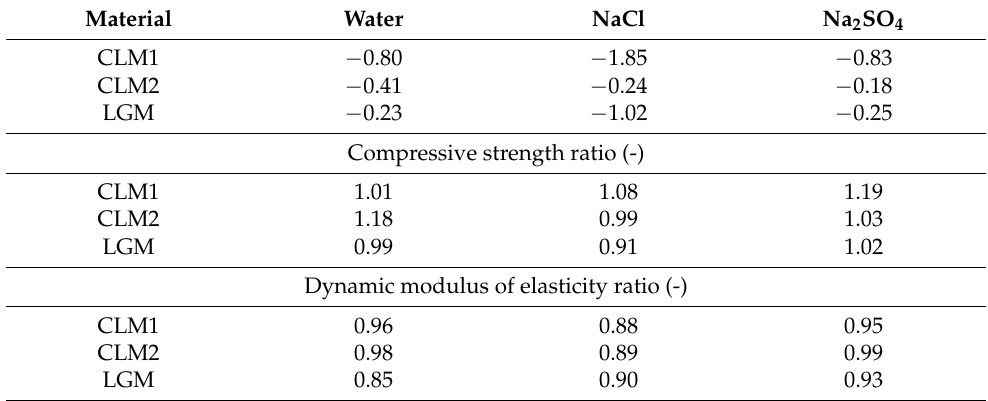
Table 9. Mass loss after the salt crystallization test (wt.%), the compressive strength, and dynamic modulus of elasticity ratios of samples subjected to salt crystallization tests and reference